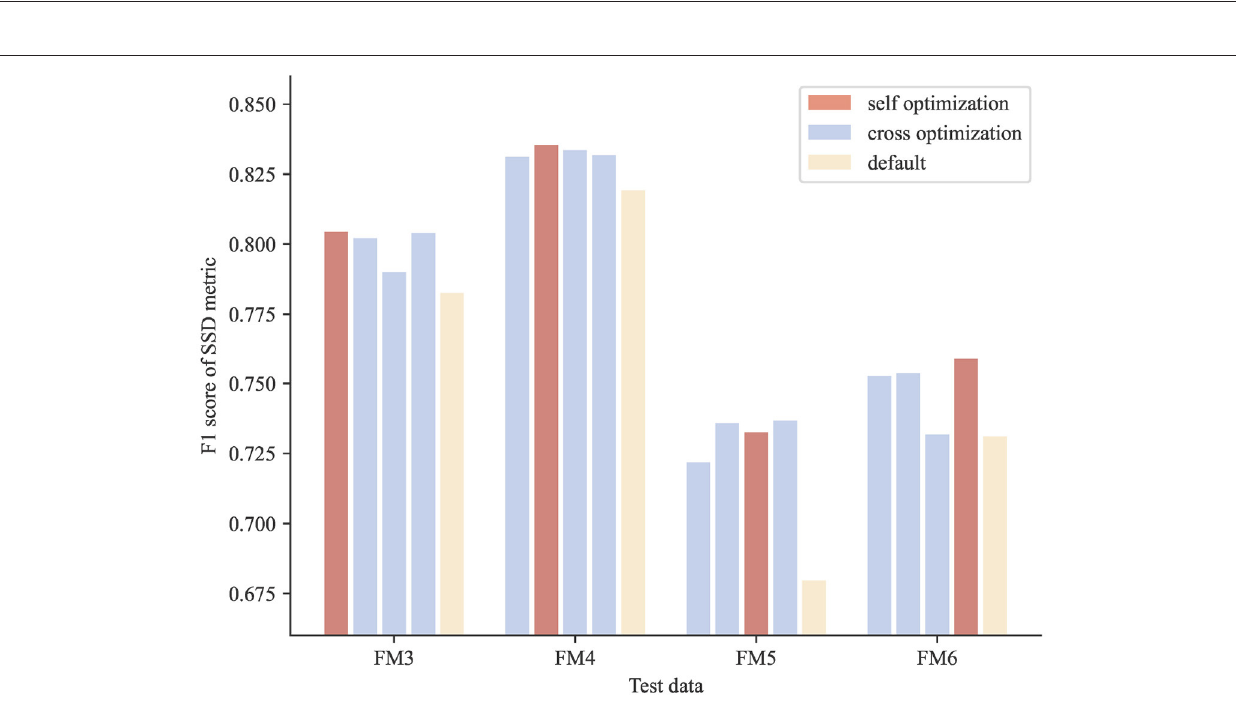
Frontiers in Neuroinformatics |